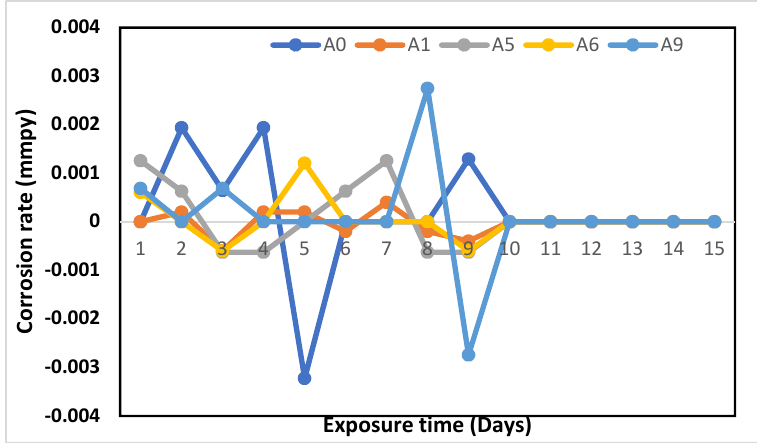
Figure 3. Corrosion rate of specimens versus the time of exposure in 3.5 wt.% NaCl solution. Figure 4a,b show the obtained surface of the samples after exposure to NaCl solution for 15 days compared with the sample not immersed in the solution (Figure 4c). The corrosion behaviors of all the specimens are similar, with surges in the positive and negative directions reminiscent of observations made during potential measurements. Such surges infer some crack and heal events occurring at the bases of all the pits.